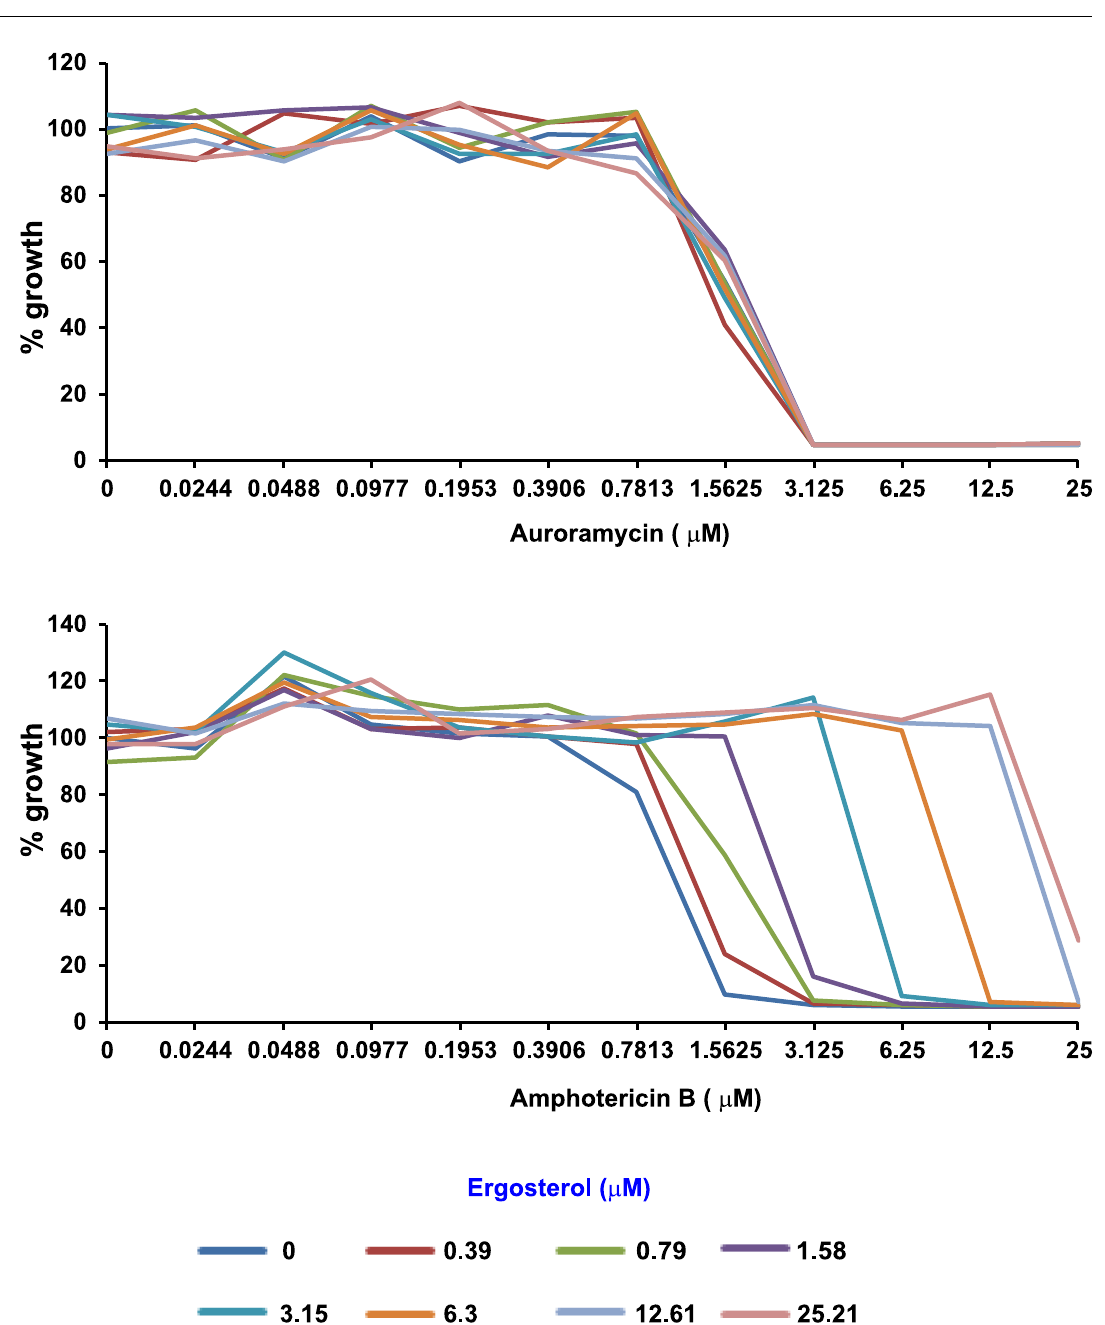
Fig 6. Auroramycin’s inhibitory effect is not via interaction with ergosterol. BY4743 cells were incubated in YPD-HEPES medium the presence of indicated concentrations of auroramycin (top) or amphotericin B (bottom) premixed with different concentrations of ergosterol in duplicate in a 96-well plate. Average growth of the duplicate cultures is plotted against the concentration of either auroramycin (upper panel) or amphotericin B (lower panel). Plots indicating the duplicate OD values with a picture of the corresponding plate are presented in S4 Fig. Representative data of one of two independent experiments are shown here. (Fig 8). For auroramycin, CFDA leakage was observed at all concentrations, even below its IC (Fig 8: left panel). In contrast, we only observed slight CFDA leakage at concentrations 50 for amphotericin B close to thrice its IC (Fig 8: right panel), which is consistent with the 50 hypothesis that a threshold amphotericin B concentration is required before membrane pores